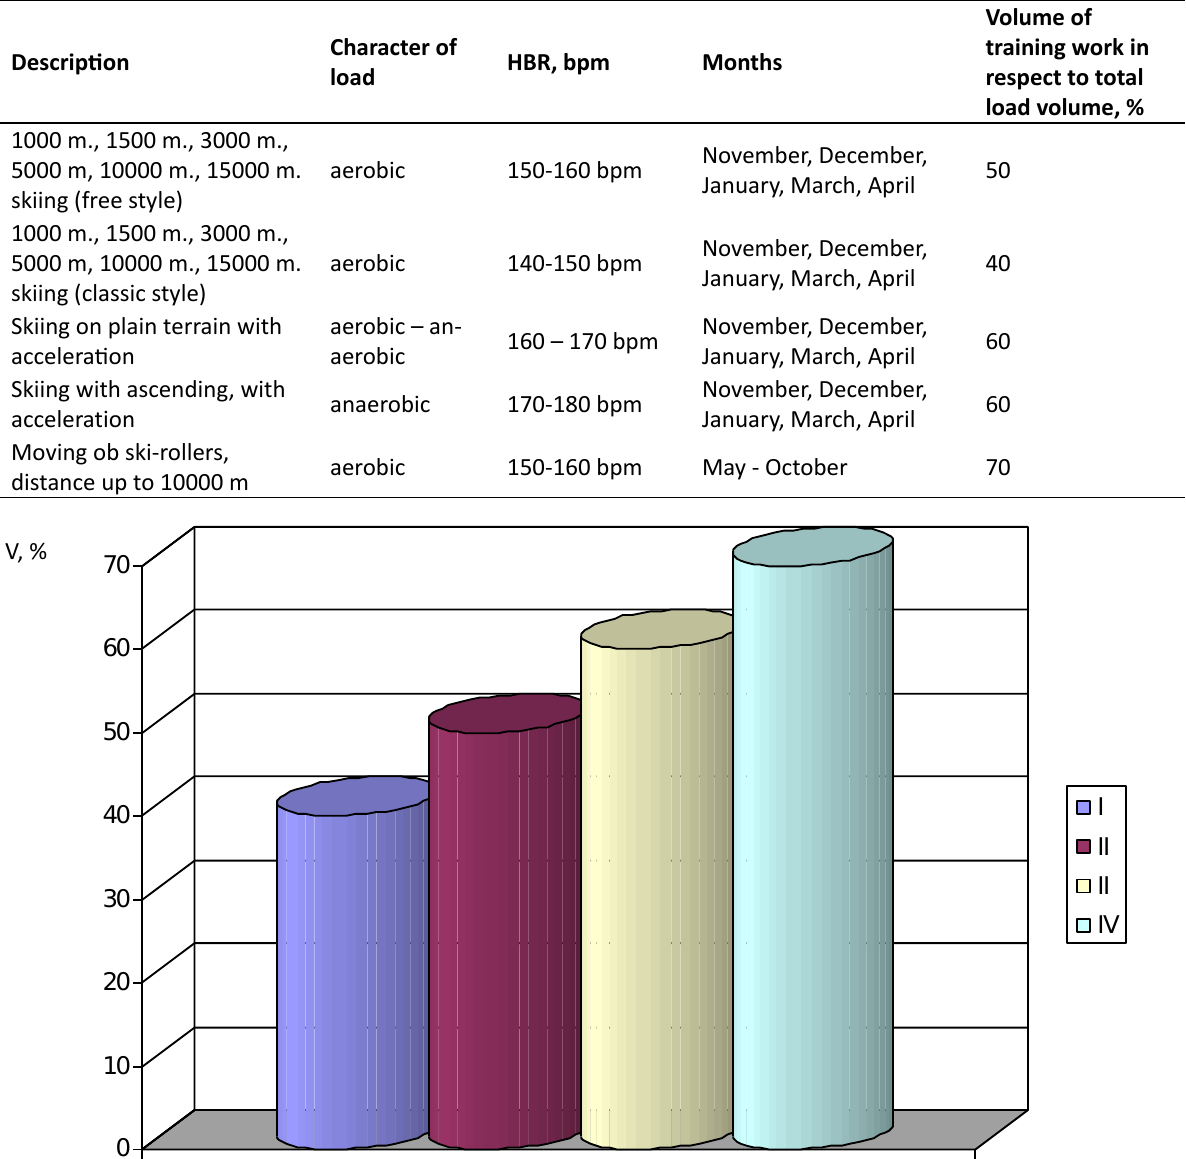
Table 1. Distribution of cyclic exercises in annual plan of skiers’ training